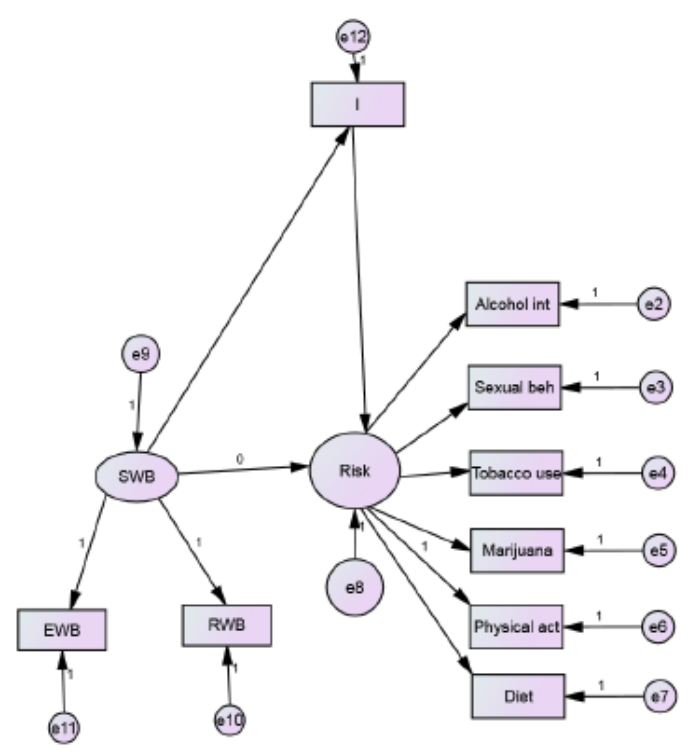
Figure 1b: Associations between spirituality/religiosity and health risk behaviours: Religiosity-mediated